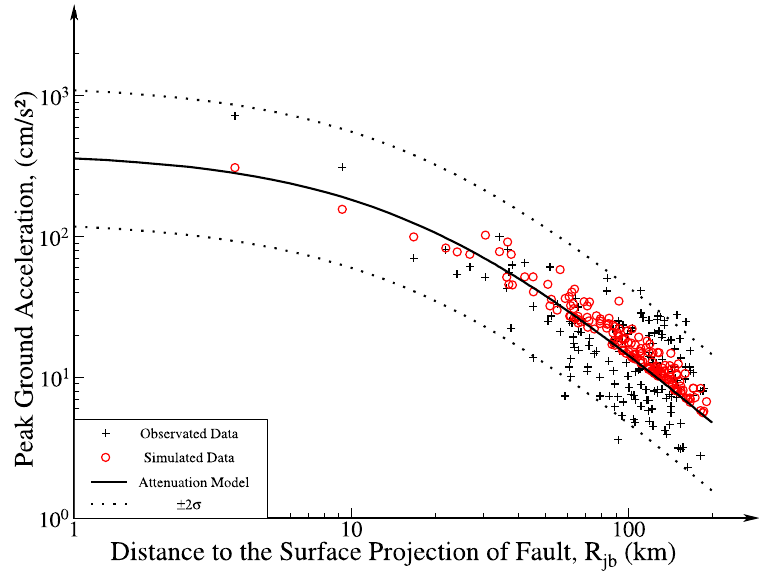
Figure 10. Comparison between the simulated and observed